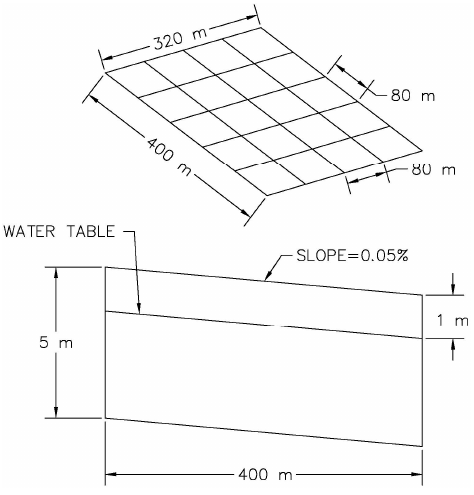
Figure 2. Infiltration Excess test case domain [15].